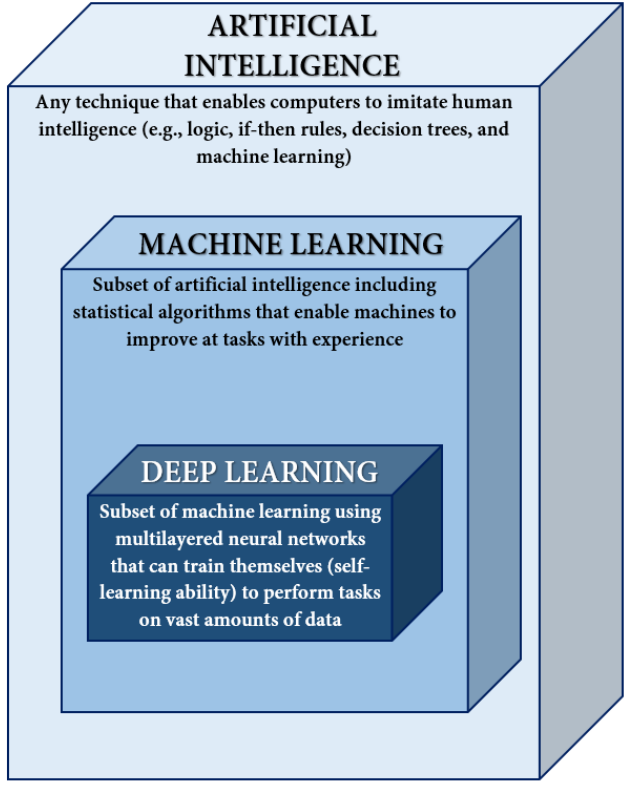
Figure 1. Relationship between artificial intelligence, machine learning, and deep learning. Adapted from an open-access source [33].